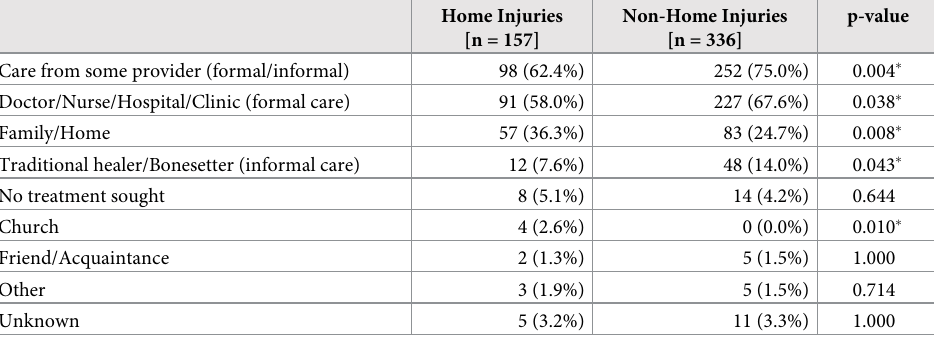
Table 3. Treatment types sought after home injuries in Cameroon.